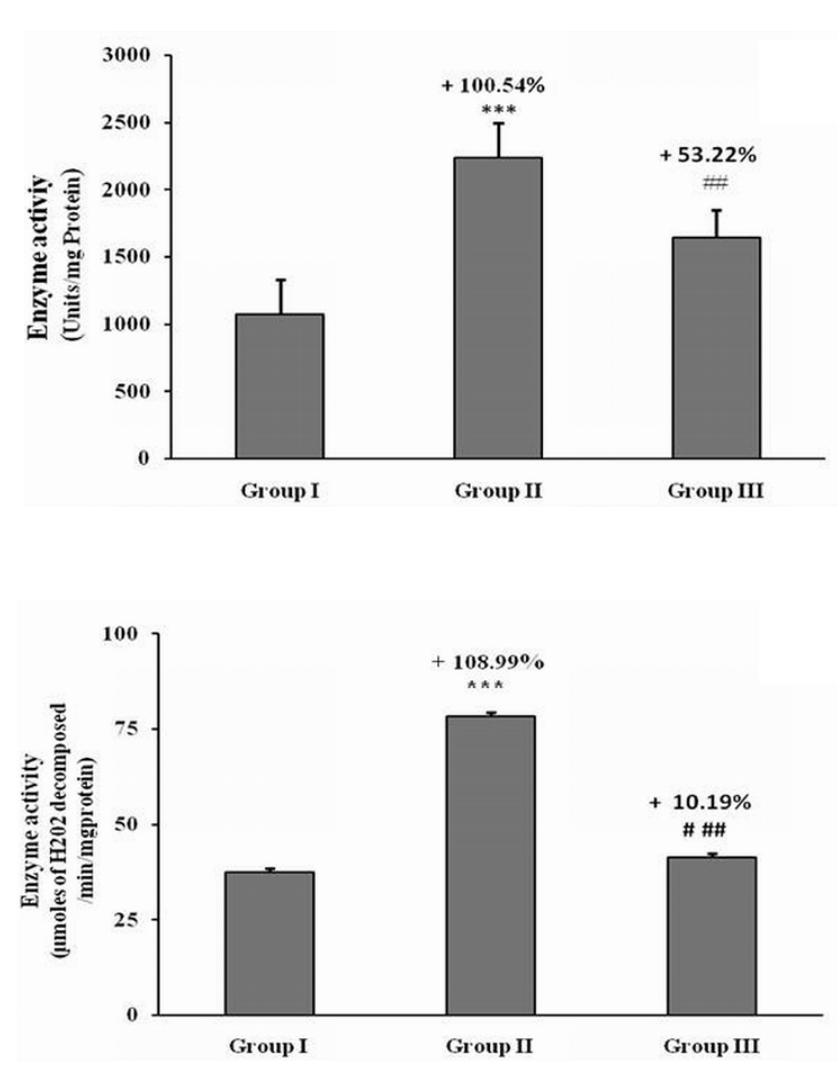
Figure 3 - Effect of coconut water administration on Superoxide dismutase (A) and Catalase activity (B) in kidney tissue of animals in different